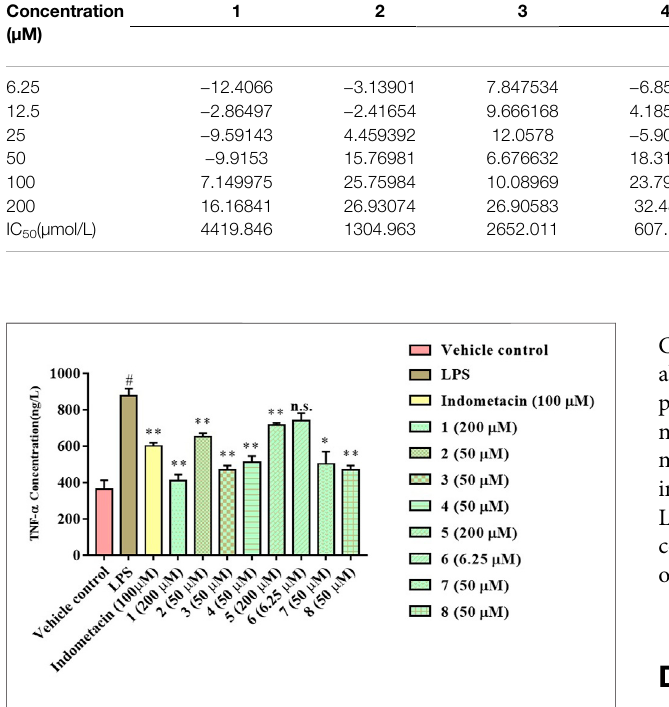
FIGURE 6 | Anti-in fl ammation assay of the isolated compounds ( # p < 0.05 vs the Vehicle control; ** p < 0.01, * p < 0.05, n.s. indicates no signi fi cant vs the LPS